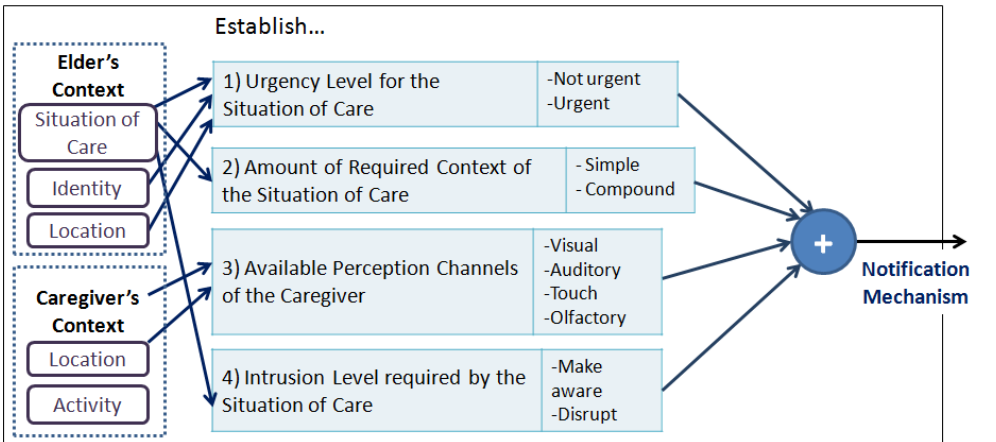
Figure 4. Model for the Design and Selection of the notification